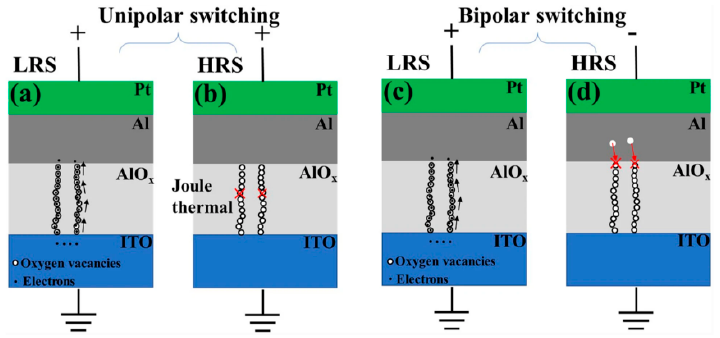
Figure 3. Switching mechanism of unipolar ( a ) ( b ) and bipolar ( c ) ( d ) AlO x -based RRAM devices, reproduced from [39], with permission from Springer Nature, 2020.